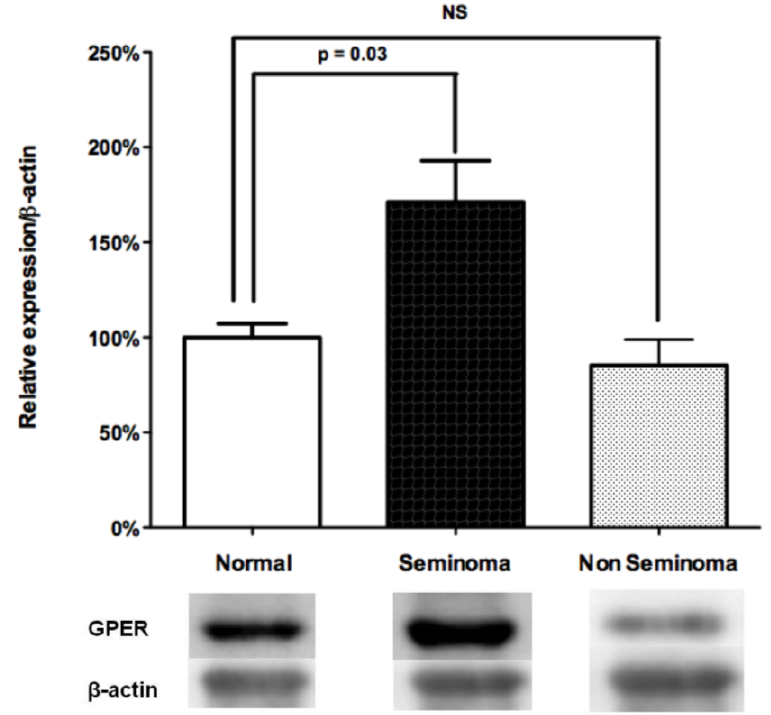
Figure 3. Analysis of relative expression of GPER protein (Western blotting) in seminomas ( n = 8) and in non-seminoma tumors ( n = 7) compared with the peri-tumoral normal testicular tissue for each patient (represented as 100%). Results are expressed as means ± S.D.; β-actin was taken in each case as a house-keeping gene; NS: non significant. Adapted from Chevalier et al .